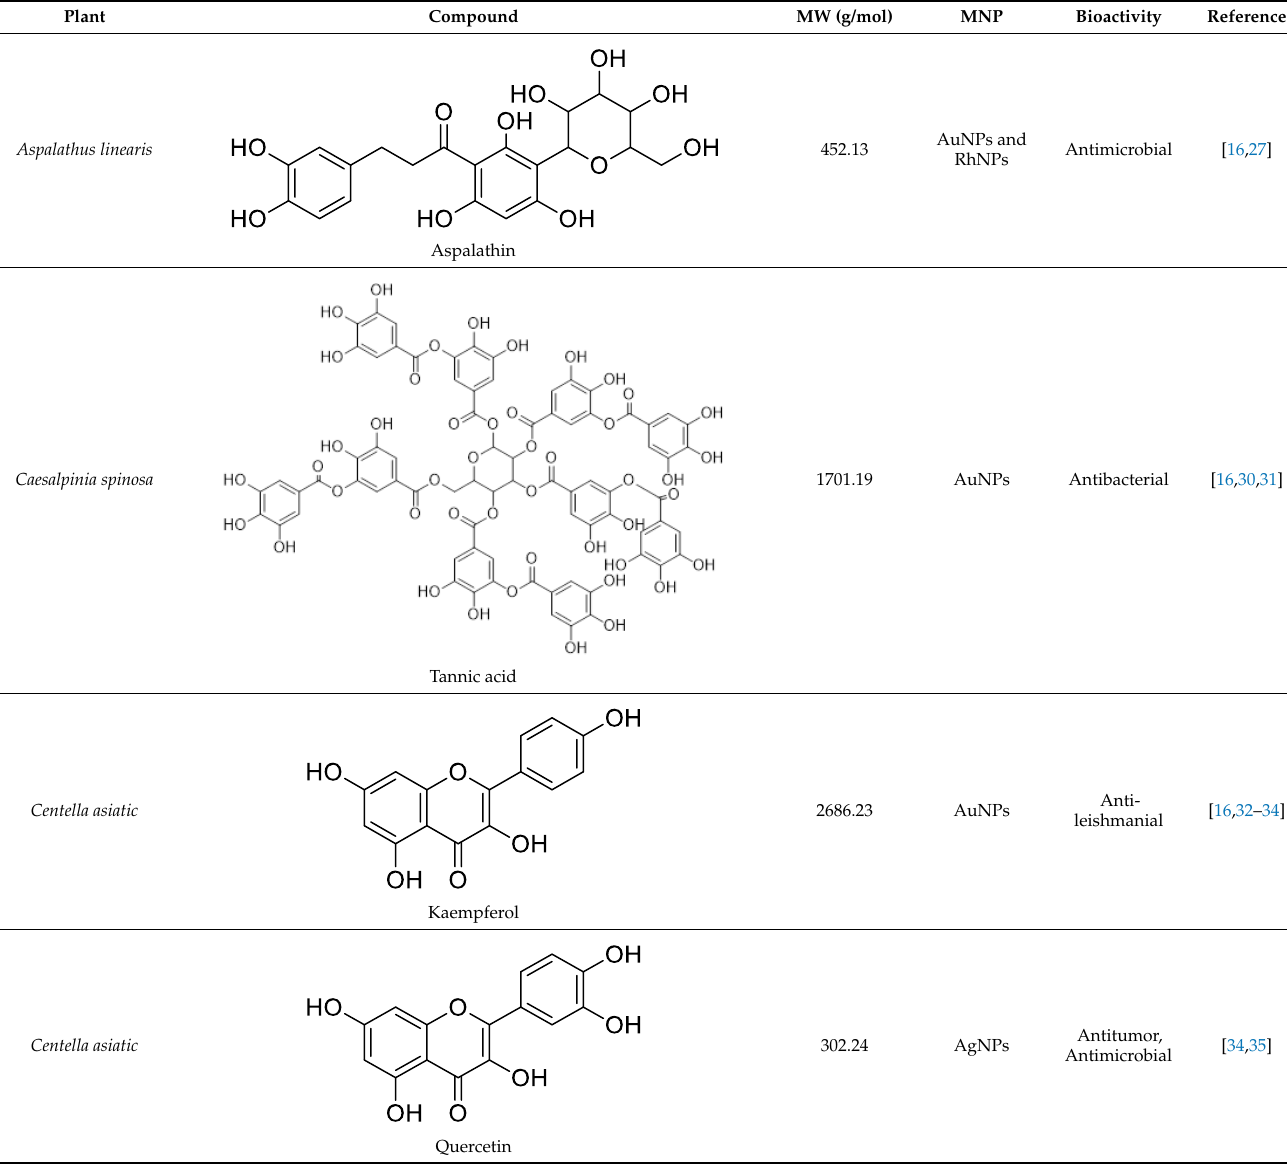
Table 1. Examples of phytochemicals that have been used in the biosynthesis of MNPs. Plant Compound